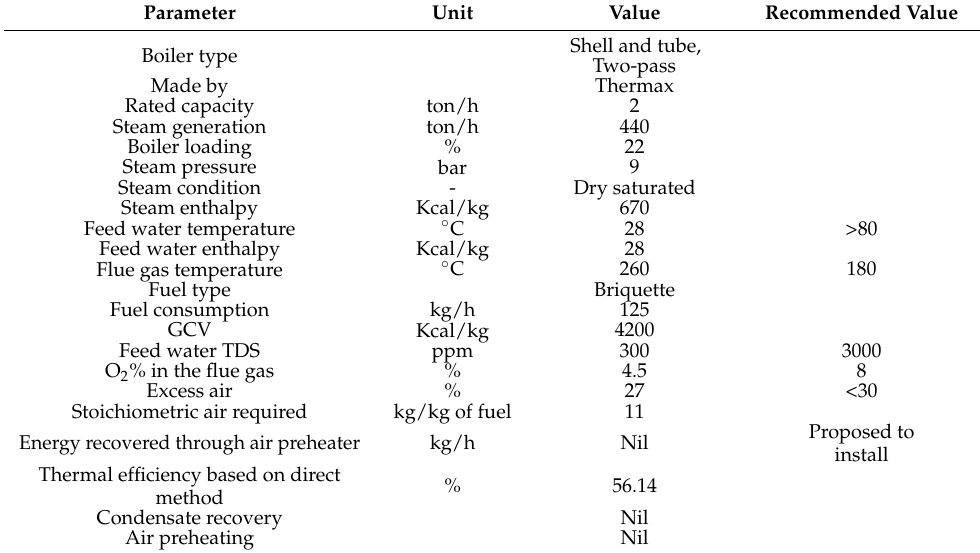
Table 9. Boiler performance study.